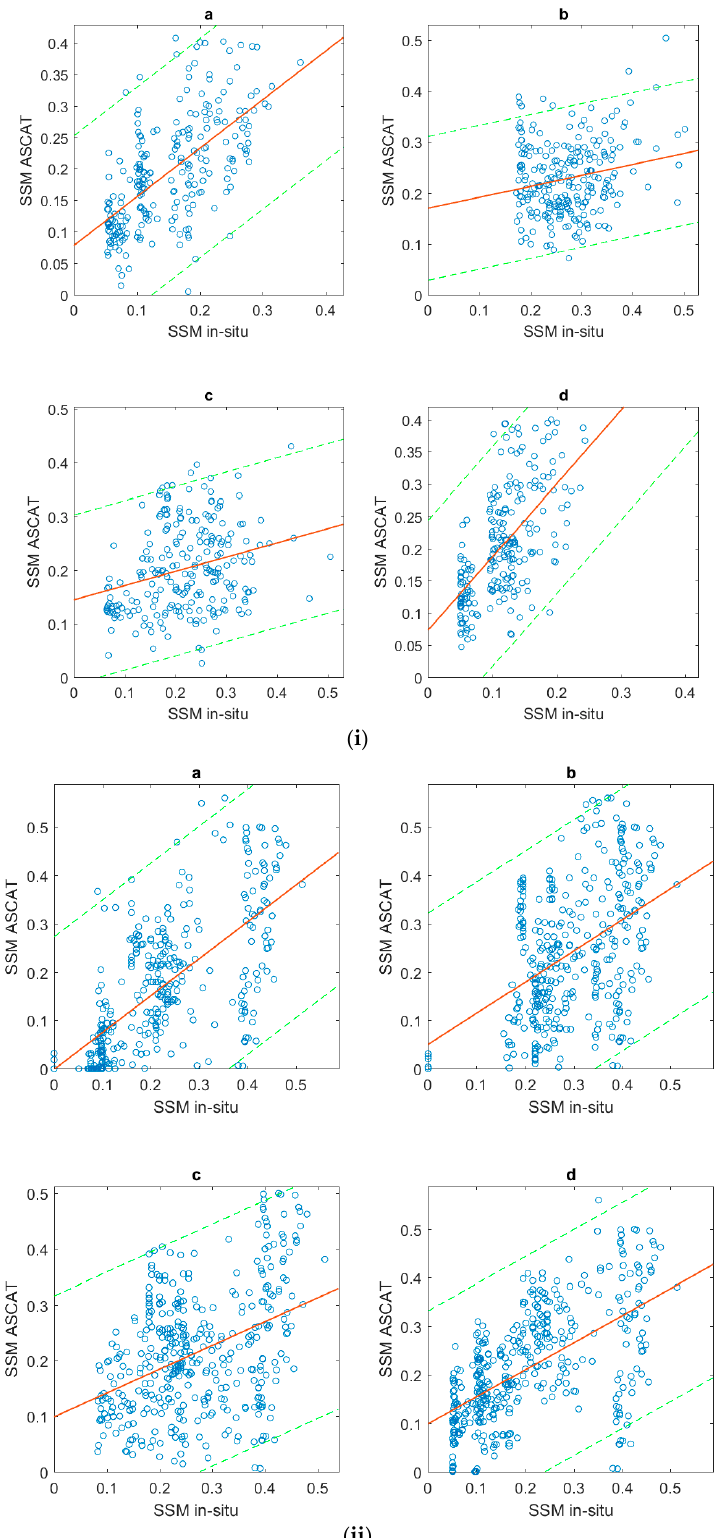
Figure 4. ( i ) Scatter diagram of in situ and predicted SSM from ASCAT 25Km for the different seasons for all sites. For all sites in EUROPE ( a ) Autumn, ( b ) Winter, ( c ) Spring, and ( d ) Summer. Shown ( i ) 2010, ( ii ) 2011. The green dashed lines represent the 95% confidence level.